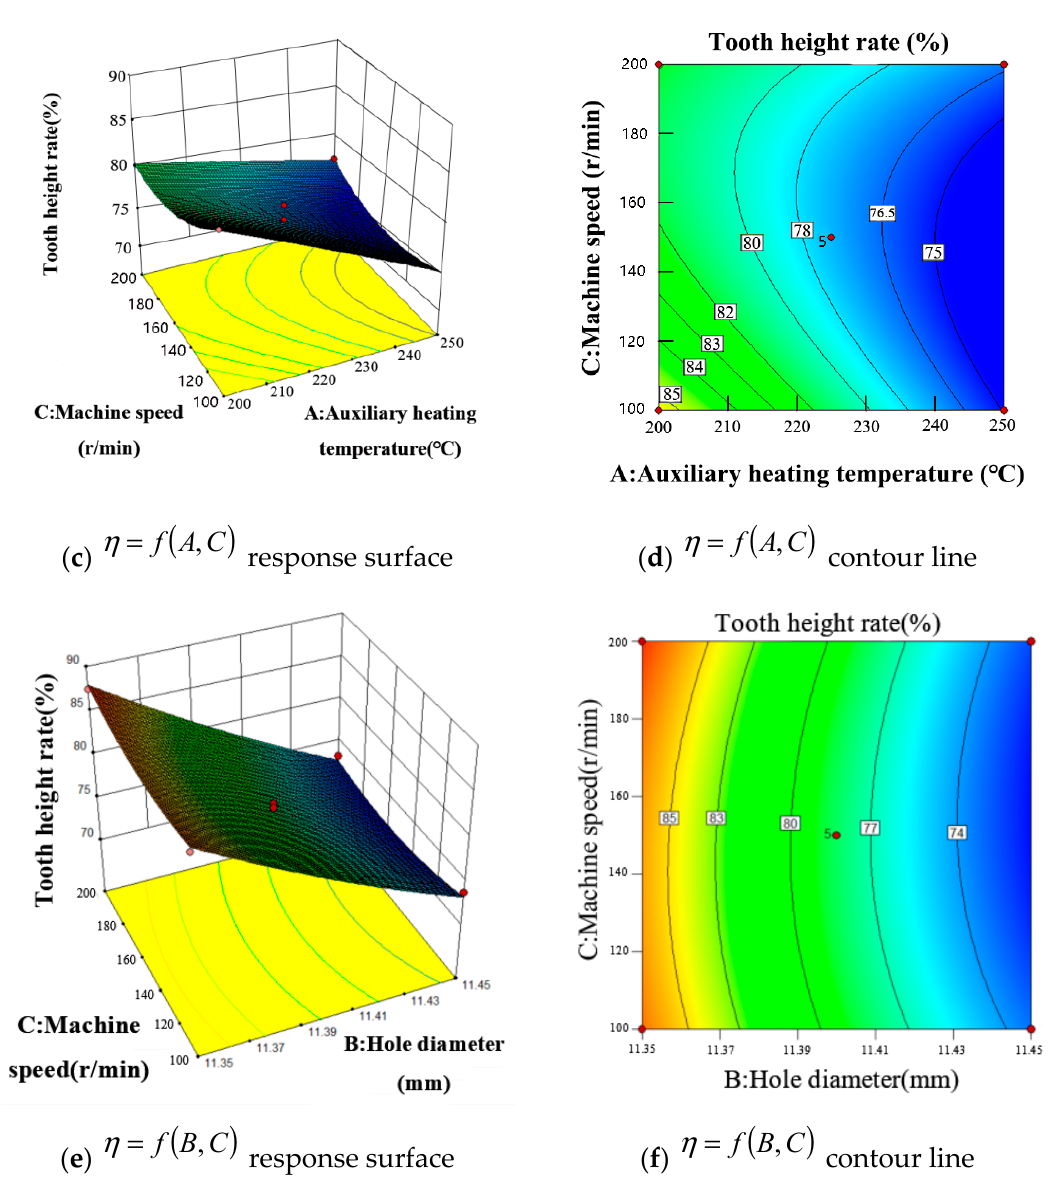
Figure 5. Response surface and corresponding contour plots showing the effect of interaction of various factors on the tooth height rate.